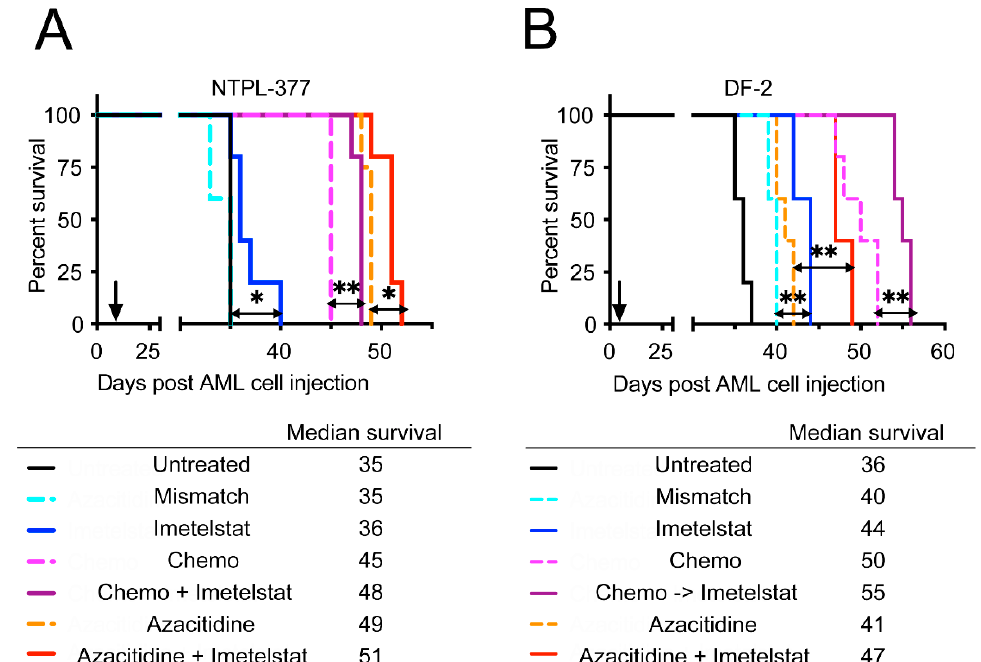
Figure 2. Kaplan-Meier survival plots showing percent survival in NTPL-377 ( A ) and DF-2 ( B ) engrafted mice receiving indicated treatments ( n = 5 per group). Chemo = chemotherapy, Chemo -> Imetelstat indicates chemotherapy followed by imetelstat. Arrows indicate time when treatment began. * p < 0.05, ** p < 0.01.